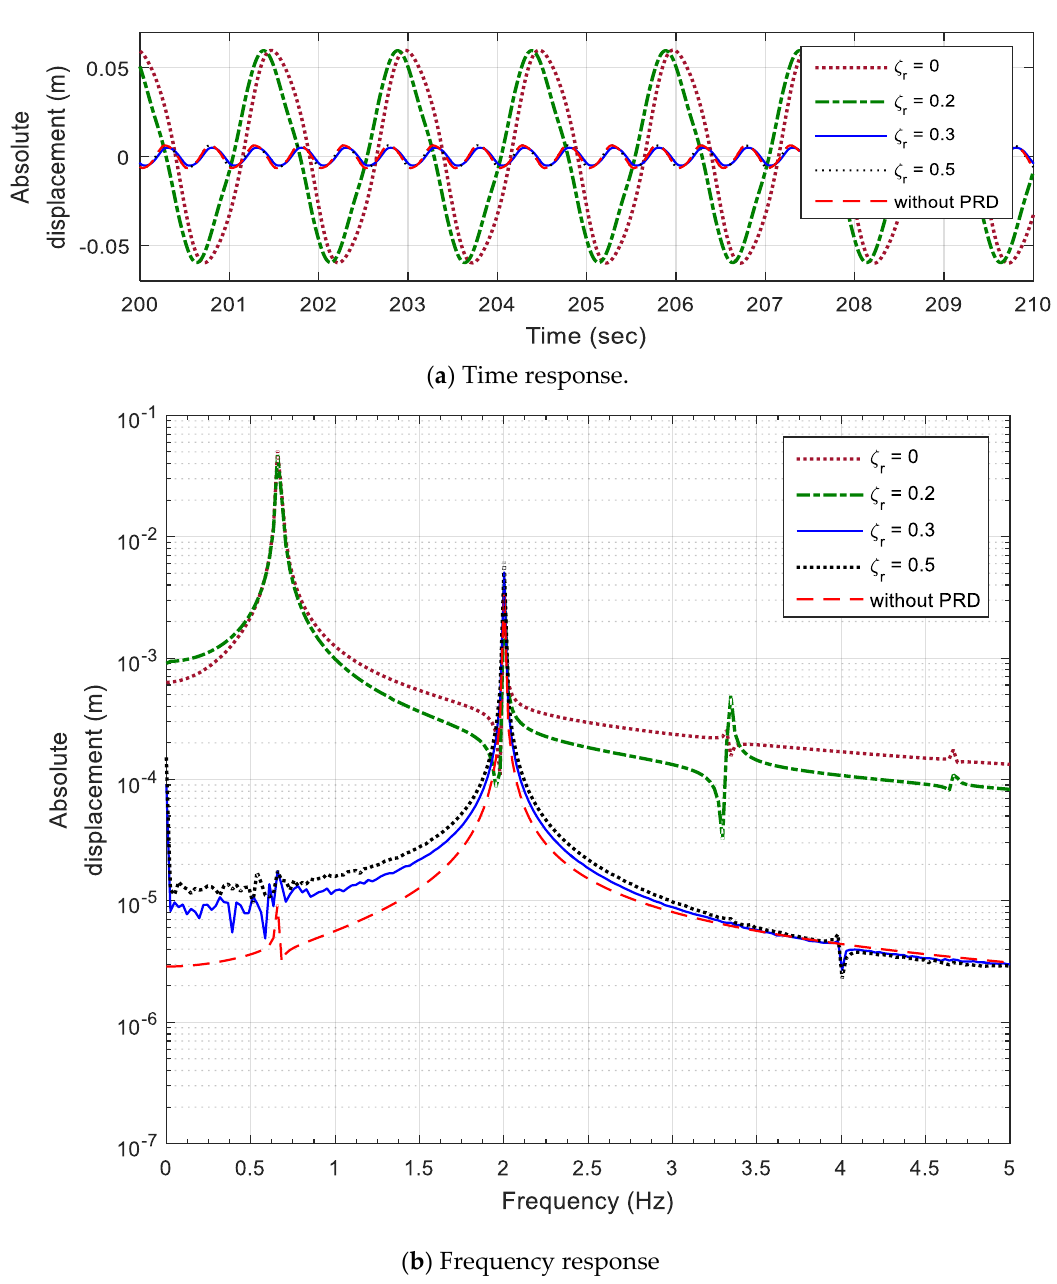
Figure 7. The change of harmonic response according to the change of damping coefficient when U = 0.03 m, f = 2 Hz and k / M = 5 .